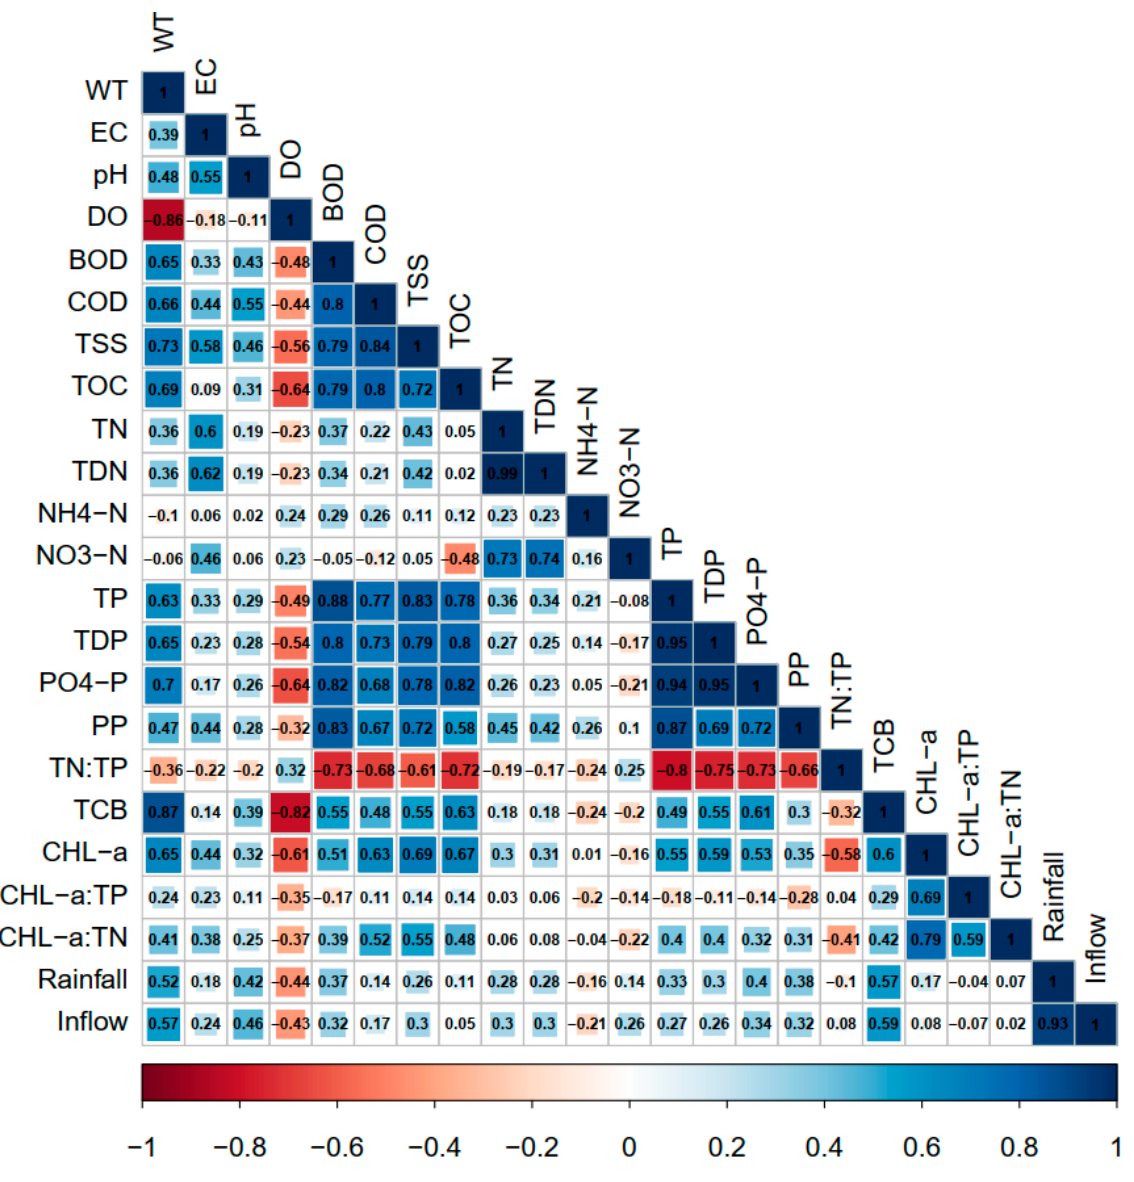
Figure 5. Pearson correlation analysis between measured water quality parameters.